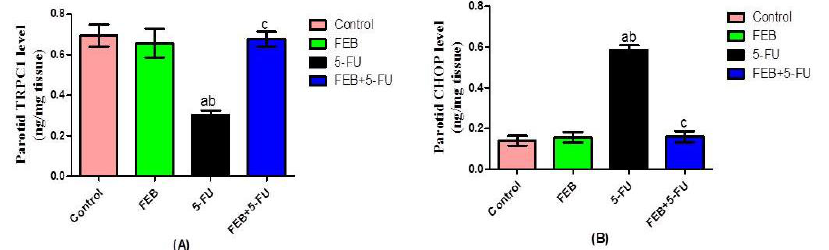
Figure 1. Impact of FEB on TRPC1 ( A ) and CHOP ( B ) in 5-FU-induced parotid salivary gland toxicity. Values are expressed as the mean ± S.D. Results were considered significantly different when p < 0.05. a Significant difference compared to the control group, b significant difference compared to the FEB group, and c significant difference compared to the 5-FU group. (TRPC1: transient receptor potential canonical1; CHOP: C/EBP homologous protein; 5-FU: 5-Fluorouracil, and FEB: febuxostat) (8 rats/group).